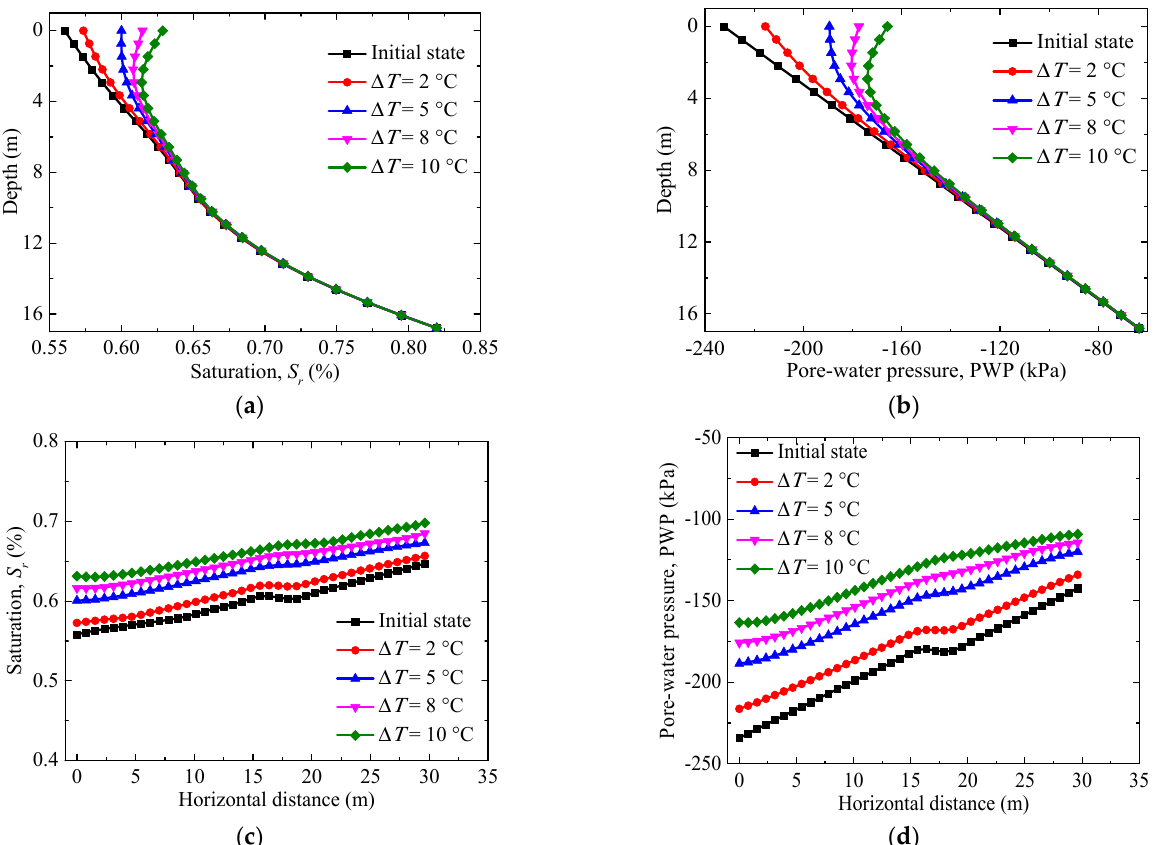
Figure 14. Effect of daily temperature variation ( Δ T ) on the ( a ) the degree of saturation profile at L1; ( b ) the PWP profile at L1; ( c ) the degree of saturation profile at L2; and ( d ) the PWP profile at L2.